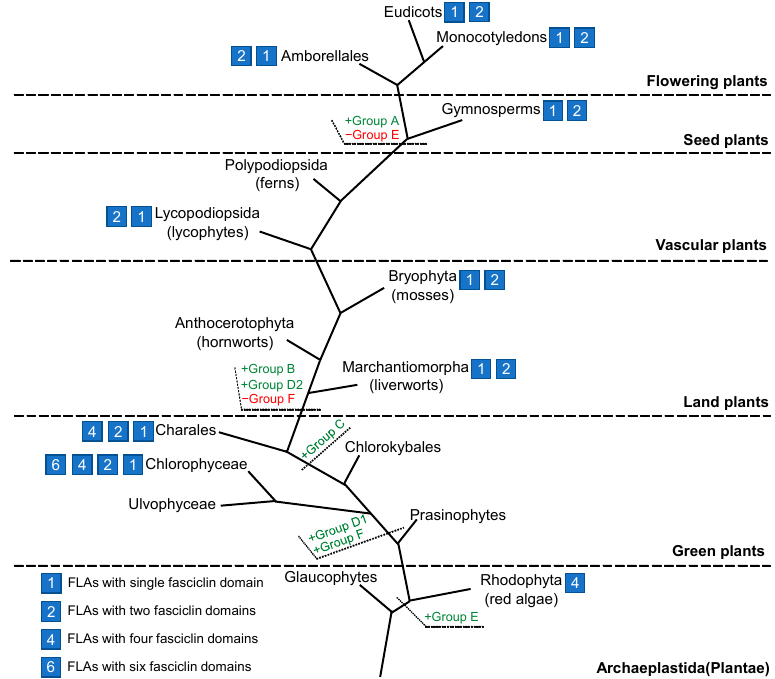
Figure 5. Evolutionary model of the FLA family in plants. The green letters display the appearance of different groups of FLAs. The red letters display the disappearance of Group E and Group F FLAs. The cubes display the number of fasciclin domains in